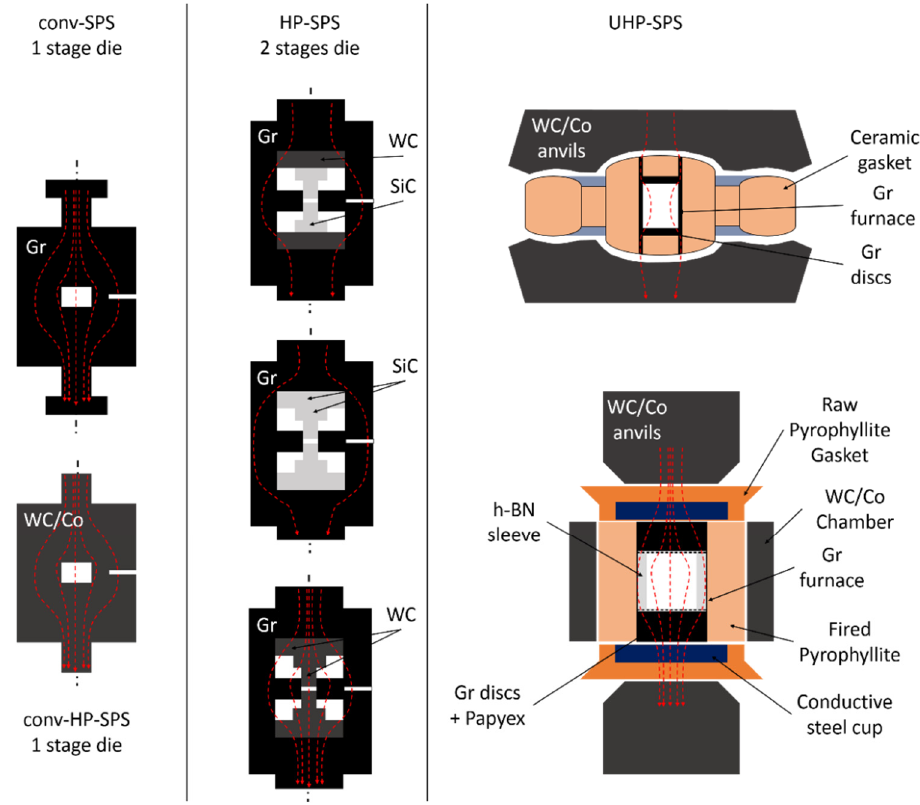
Figure 1. Drawing representing the different SPS assemblies and pathways of the injected current (red arrows). Conv-SPS assemblies ( left columns ) showing the mold contents, the sample and the furnace. These assemblies consist of mold mostly in graphite (Gr) to reach P max = 0.1 GPa and T max ~ 2500 °C and for HP-SPS in WC/Co to reach P max = 1 GPa at low temperature ( 100–200 °C ) (higher temperature for lower pressure is also possible). HP-SPS special assemblies ( middle columns ) in conventional equipment are more sophisticated and consist of double stage mold with an outer shell (acting as furnace) and inner die in graphite with hard materials discs/pistons (SiC and or binderless WC). In that case, P max = 1 GPa and T max = 1100 °C can be reached but the current pathway depends on the composition of pistons and discs. Therefore, the SPS process does not necessarily occur. In UHP-SPS setups ( right column ), assemblies are much more complicated to ensure good hydro- staticity. Typically, a ceramic cell is used to receive a thin wall graphite furnace in which powder is loaded. Powder is then packed between graphite punches inside the graphite tube furnace that al- low current injection inside the sample (SPS principle). Hence, P max = 6–8 GPa and T max = 2000 °C can be achieved.